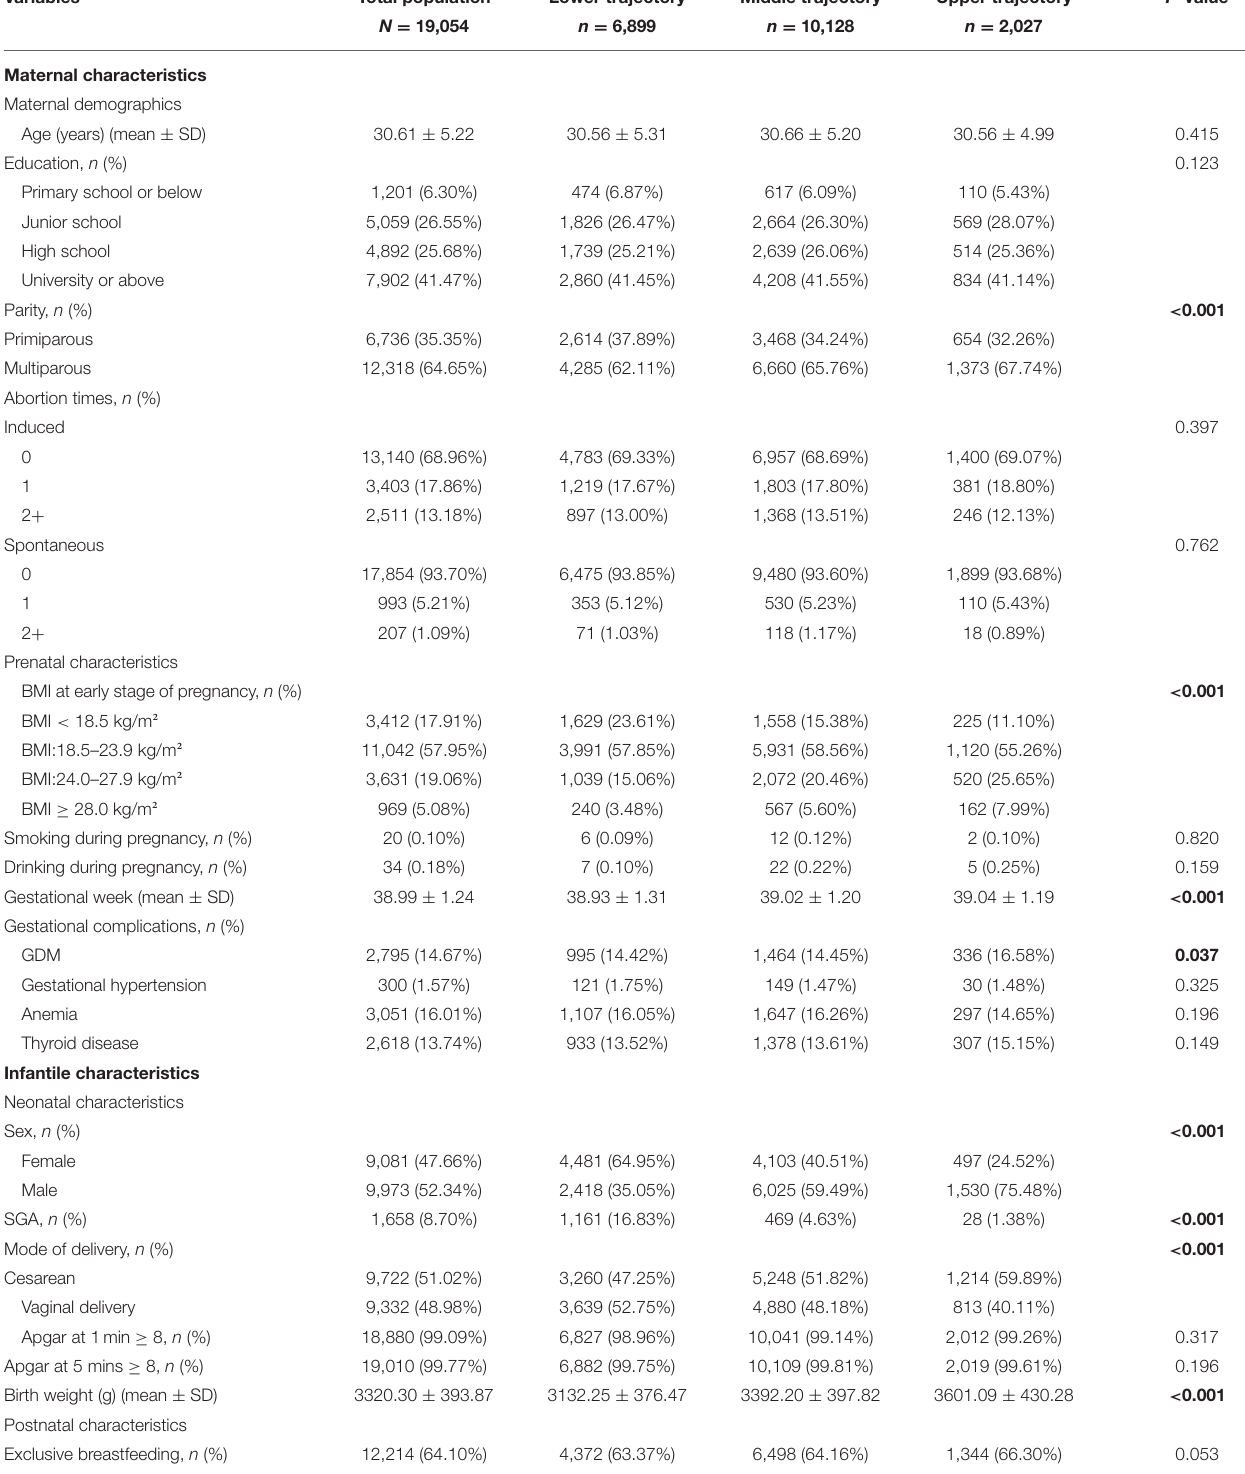
TABLE 1 | Characteristics of mother-child pairs by BMI